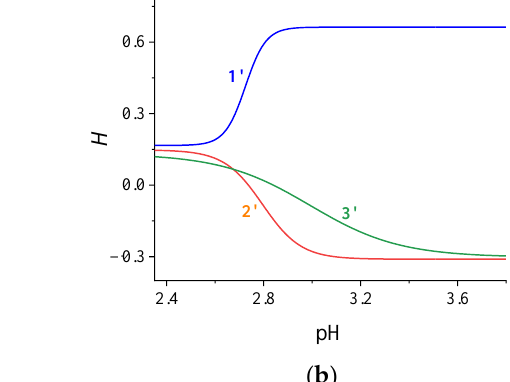
absence (full curves) and presence of surfactant (dashed curves) vs. logC I · p . The colored symbols refer to the curves of Figure 4a. In general, s pH decreases with the increase in C I , since ∆ increases with the concentration more than the slope decreases. It occurs up to a value of logC I · p close to − 3.82. At larger C I values of s pH increase as the color saturates approach black. The prediction error between logC I = − 4.45 and − 4.00 is minimum and approximately constant. Between − 4.43 and − 4.31, the inversion takes place so that s pH slightly increases passing close to the achromatic point—where the color is absent and S =